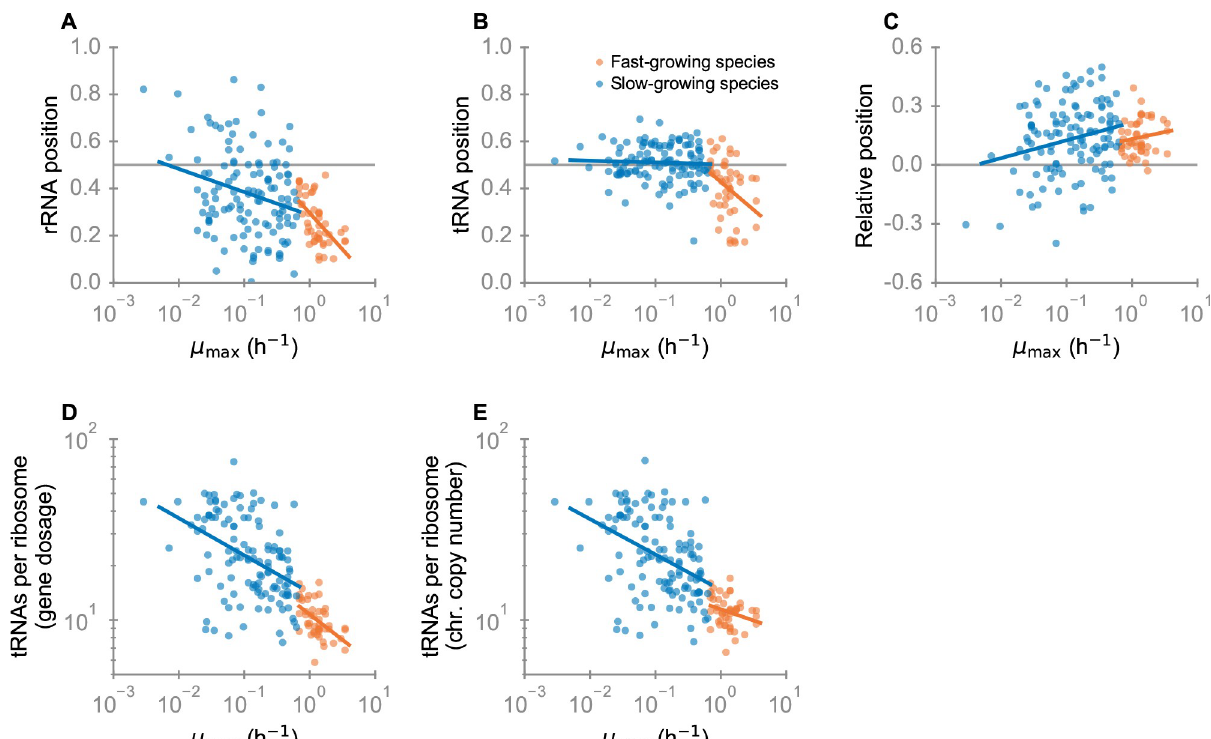
Fig 3. The genomic positions of rRNA and tRNA genes implement the RNA growth law in fast-growing species. (A) Arithmetic means of the . The horizontal grey line (position 0.5) marks the midpoint between origin and terminus rRNA positions for individual genomes as a function of μ max of replication. (B) Same for tRNA. (C) Relative positions between tRNA and rRNA genes ( position tRNA — position rRNA ). (D) tRNA/rRNA gene dosage ratios. (E) Genomic tRNA/rRNA ratios (per chromosome). Blue points indicate slow growing species (with blue linear regression line), orange points indicate fast-growing species (with orange linear regression